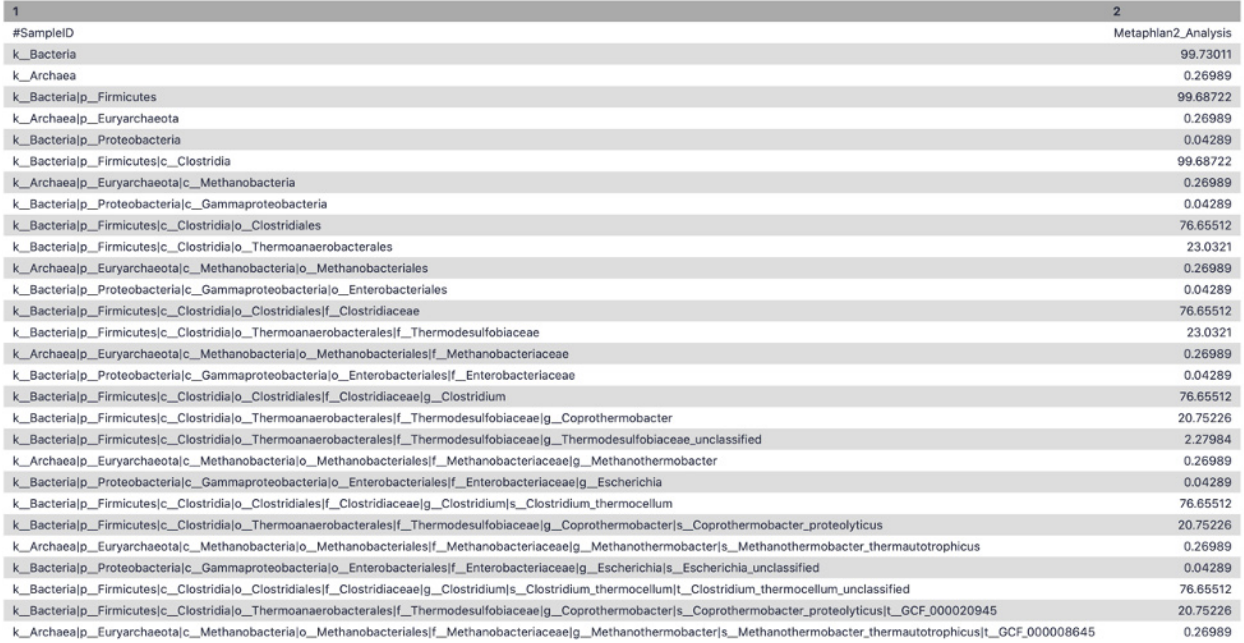
The HUMAnN2 suite of tools were used to extract func- tional information along with their relative abundance (RPK). their abundance ( Extended data : Supplementary Figure S2a 49 ), pathways and their abundance ( Extended data : Supplementary Figure S2b 49 ) and pathway and their coverage ( Extended data : Supplementary Figure S2c 49 ).